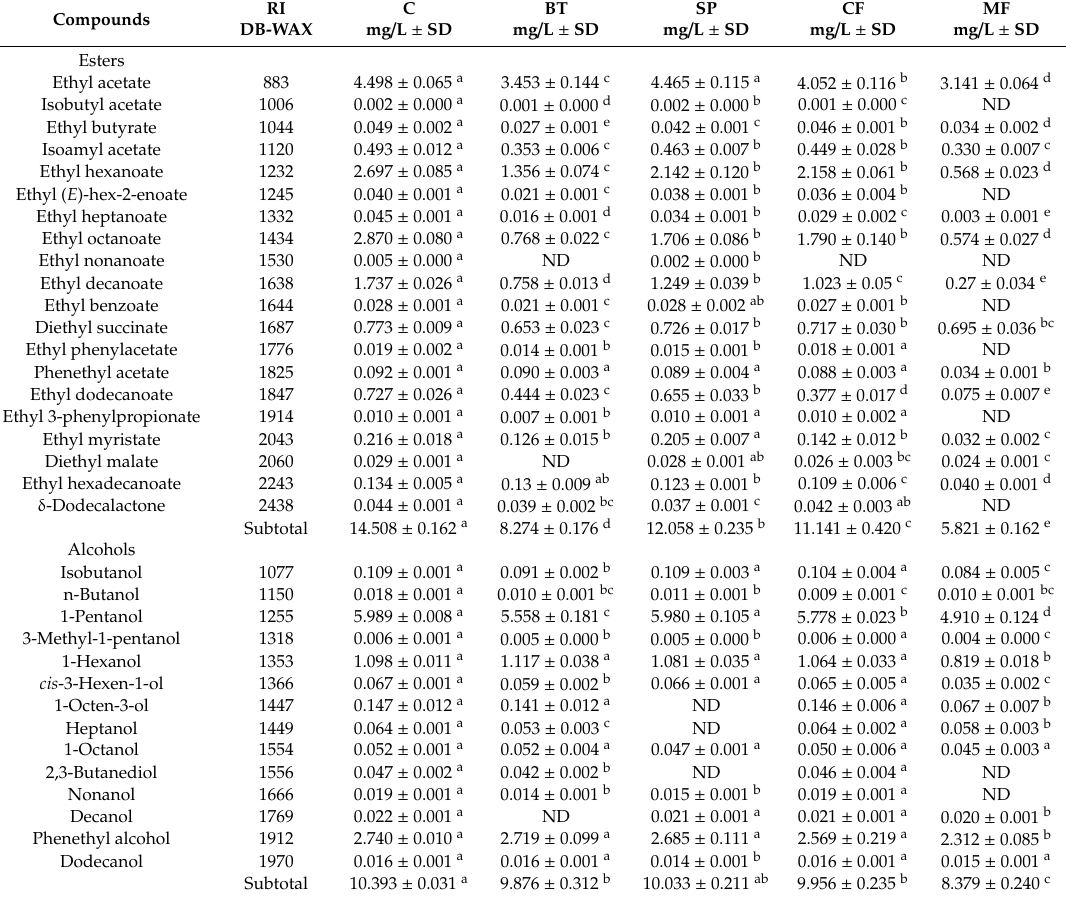
Table 2. Volatile compounds and concentration (mg / L) with standard deviation (SD) of ‘Italian Riesling’ icewine